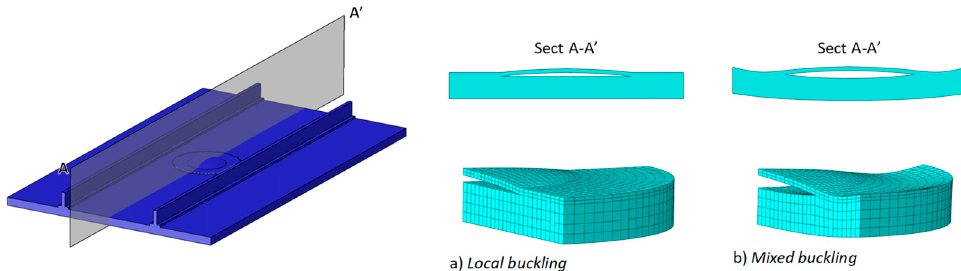
Figure 1. Delamination buckling scenarios: ( a ) Local buckling of the thinner sub-laminate and ( b ) Mixed buckling of both sub-laminates.